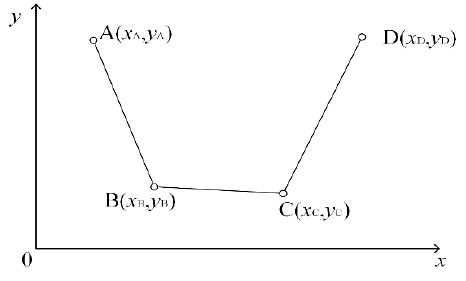
Figure 11. Establishment of coordinate system for single section of groove (welding operations are carried out in turn along the x-axis during cross welding).